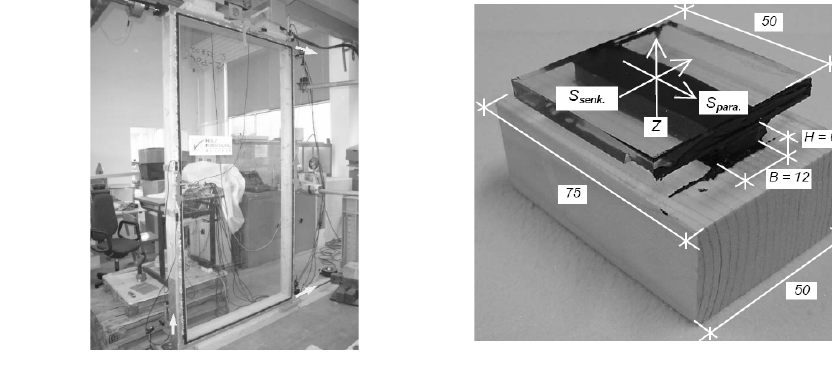
Figure 7: The test set-up [9]. Figure 8: Specimens of a structural sealant glazing system with timber